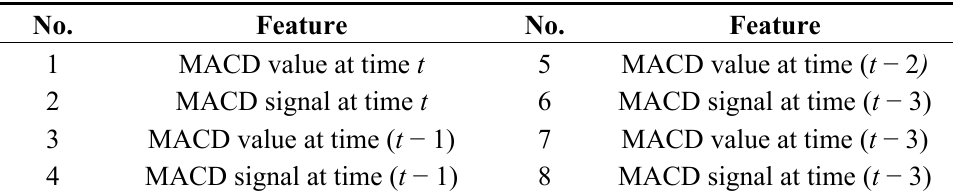
Table 1. Features for each kernel in the MKL